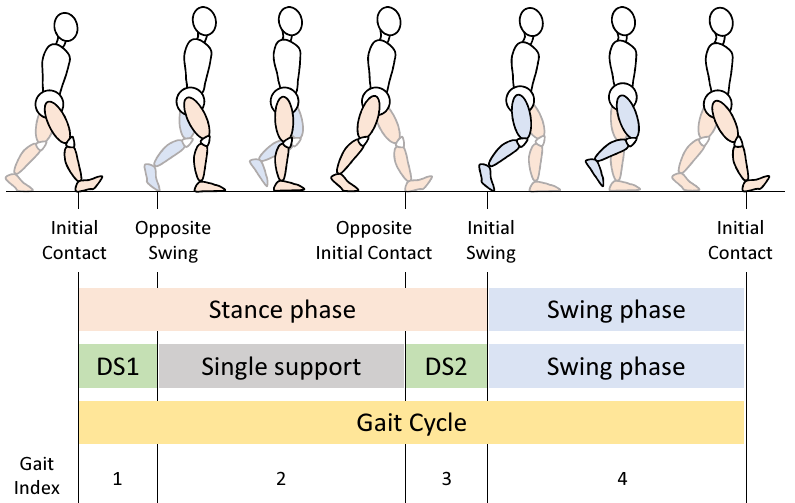
Figure 5. Gait patterns of a leg: one gait cycle is from when the foot initially contacts the ground to when the foot contacts the ground again. DS1 and DS2 mean the first and the second double limb support phases,